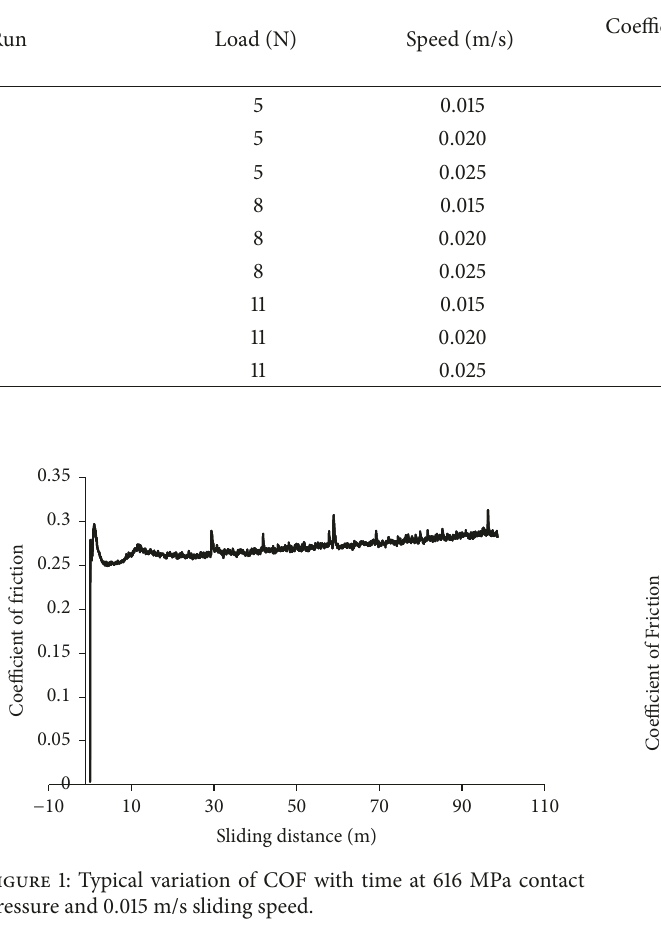
Figure 2: Variation of coefficient of friction with contact pressure and sliding